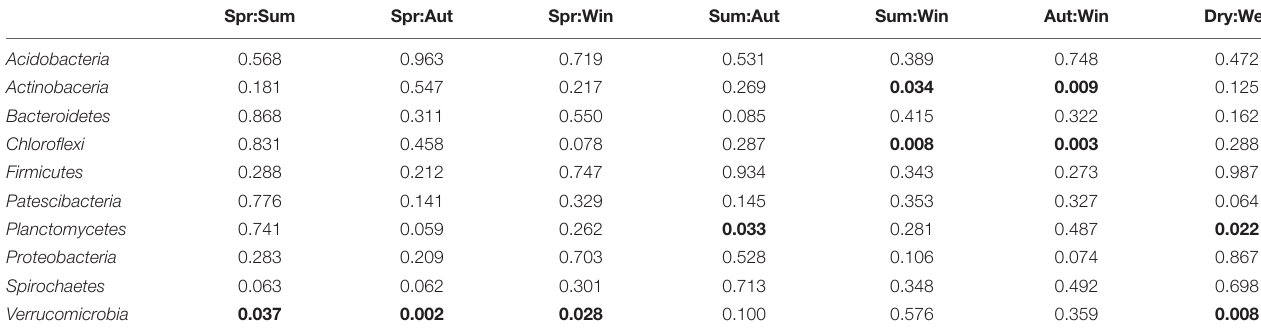
TABLE 4 | Summary of temporal differences in relative abundances of dominant bacterial phyla in microbial communities (Welch’s t -test, P < 0.05).